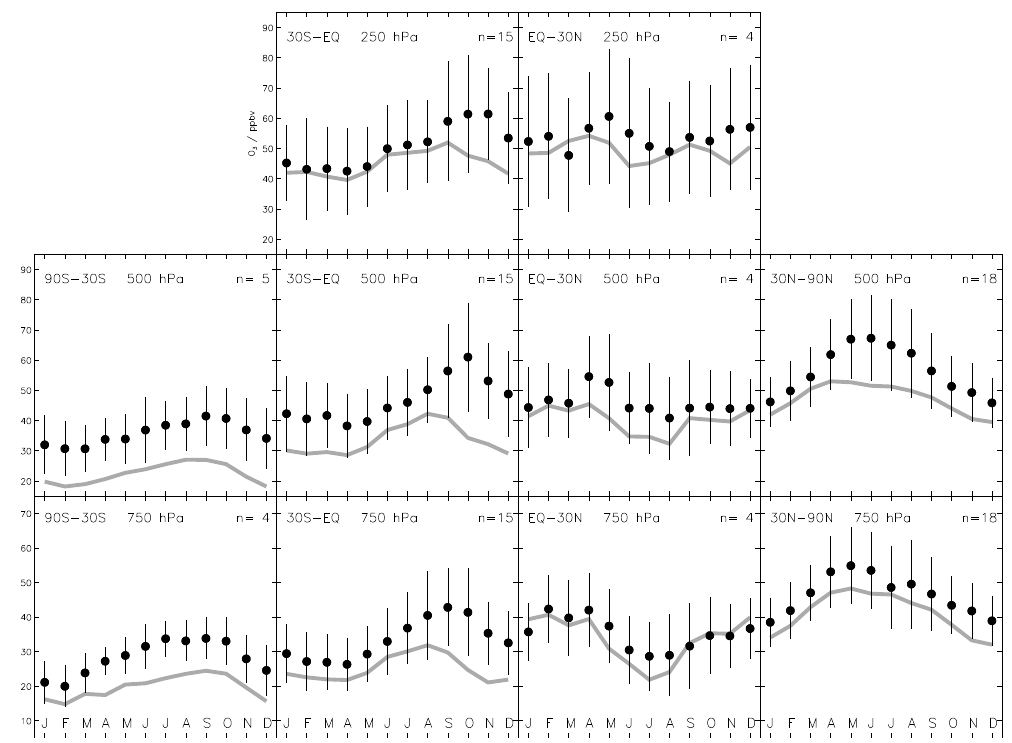
Fig. 5. Comparison of the annual cycle of ozone observations (black dots) and monthly mean O 3 for the year 2000 simulation (gray lines) at different latitude bands and at different pressure levels (750hPa, 500hPa and 250hPa). O 3 sonde data are from Logan (1999) and Thompson et al. (2003a, b). The number of sites is given in the top right corner of each plot. The figure is similar as in the multi model study by Stevenson et al. (2006).